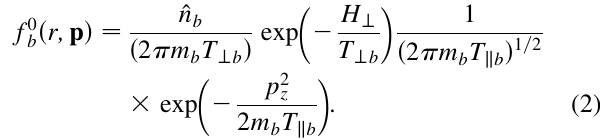
(thick line), f (cid:7) 0 : 8 and T (cid:7) 0 : 02 . =T k b ? b b